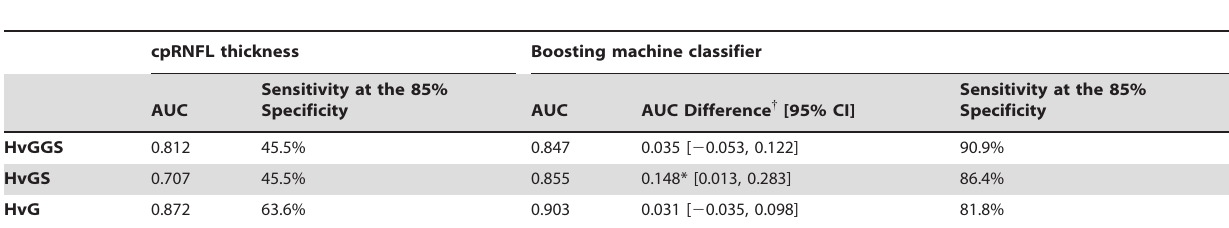
Table 4. Area under the receiver operating characteristic curves (AUCs) computed with machine classifier and Cirrus HD-OCT software generated mean cpRNFL